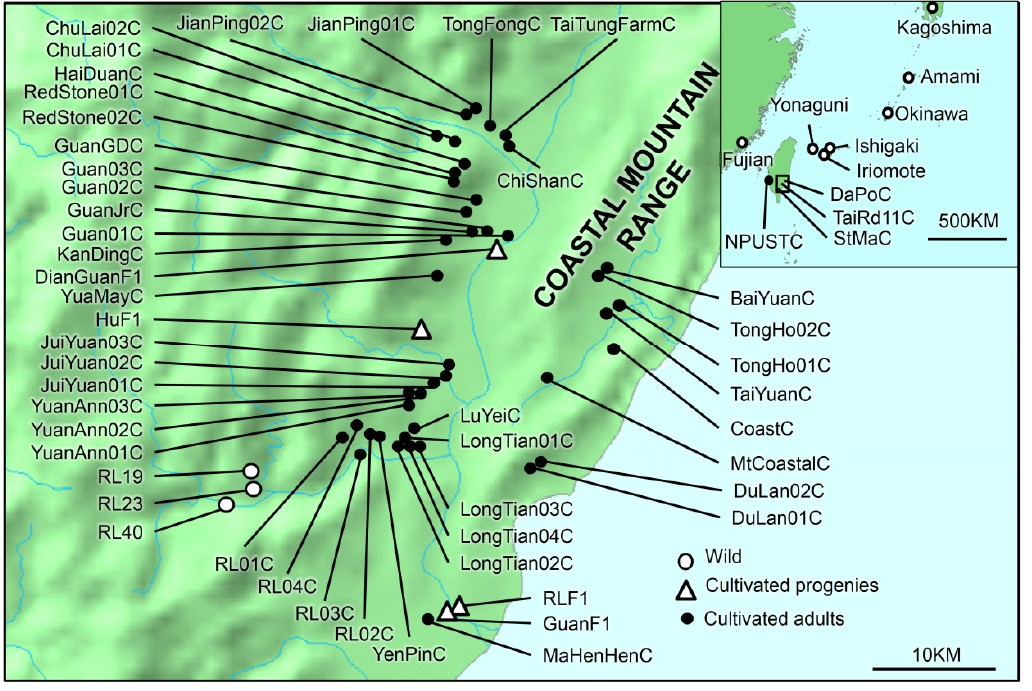
C. taitungensis in the southeast Taiwan and the upper-left panel indicates the sampling sites of C. revoluta . Wild populations, cultivated adults and progenies are marked in hollow circles, full circles, and hollow triangles, respectively. Codes of the sampling sites correspond to Table